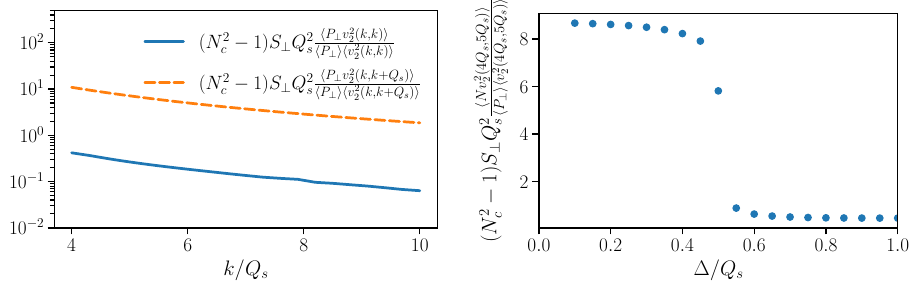
¯ k (cid:5) . Kinematics is the same as in Fig. 2. Right panel: the three particle correlation (cid:4) v 2 2